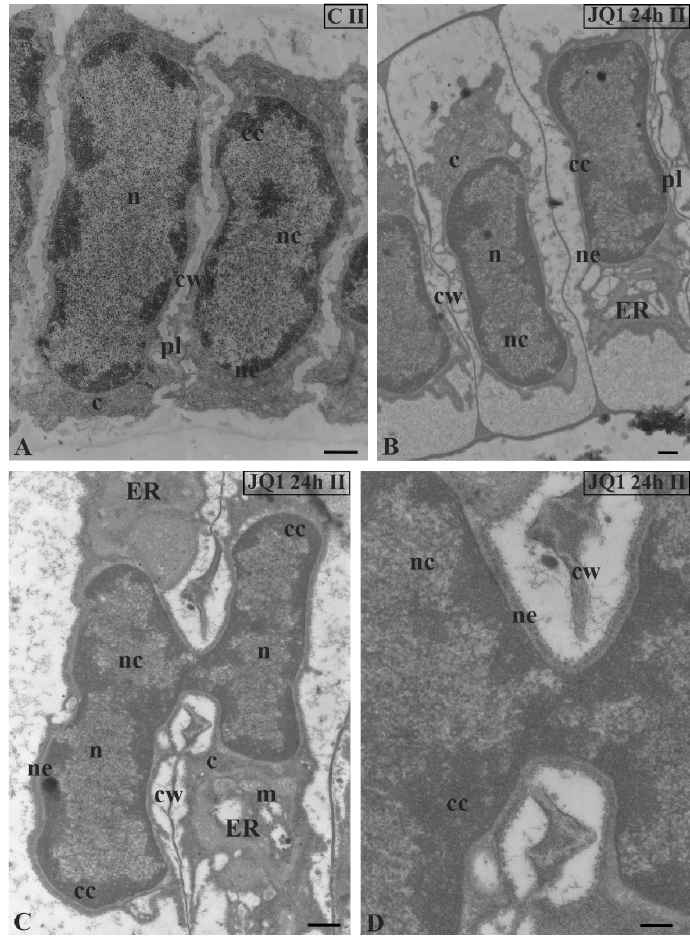
Figure 3. The effect of JQ1 on C. vulgaris spermatids at stage II after 24 h treatment. ( A ) the control; ( B – D ) after treatment with JQ1; ( C ) The fusion of two spermatid nuclei on a longitudinal section; ( D ) magnification of the fusion site with visible continuity of the nuclear envelope and broken cell wall between spermatids; c, cytoplasm; cc, condensed chromatin; cw, cell wall; ER, endoplasmic reticulum; m, mitochondrion; n, nucleus; nc, non-condensed chromatin; ne, nuclear envelope; on individual images in the frame treatment, time of treatment and stage of spermiogenesis were given; Scale bars = 500 nm ( A – C ), 200 nm ( D ).